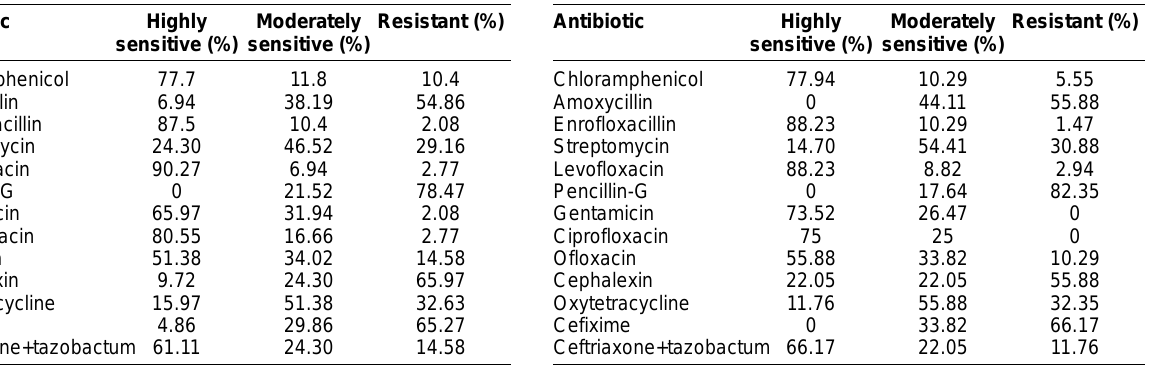
Table-3. Antibiogram of Staphylococcus isolates